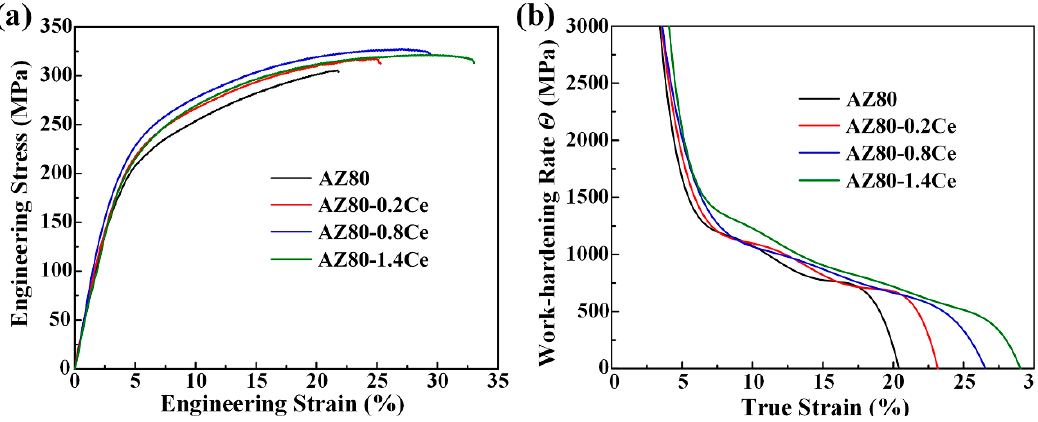
Figure 5. ( a ) Tensile engineering stress–strain curves of as-extruded alloys; ( b ) corresponding work-hardening rate Θ vs. the true strain of ( a ). Table 2. Tensile properties of the as-extruded AZ80 alloys with different Ce.